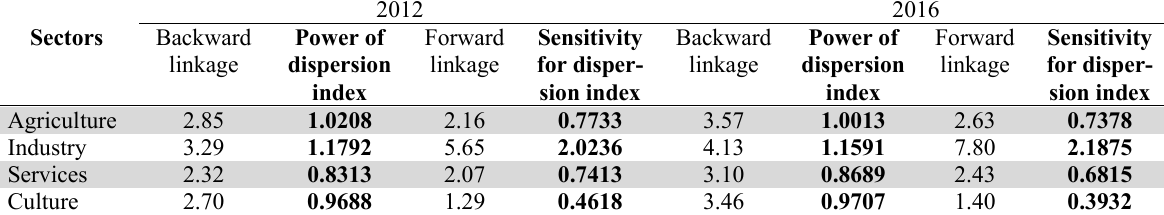
Power of dispersion and sensitivity of dispersion indexes of